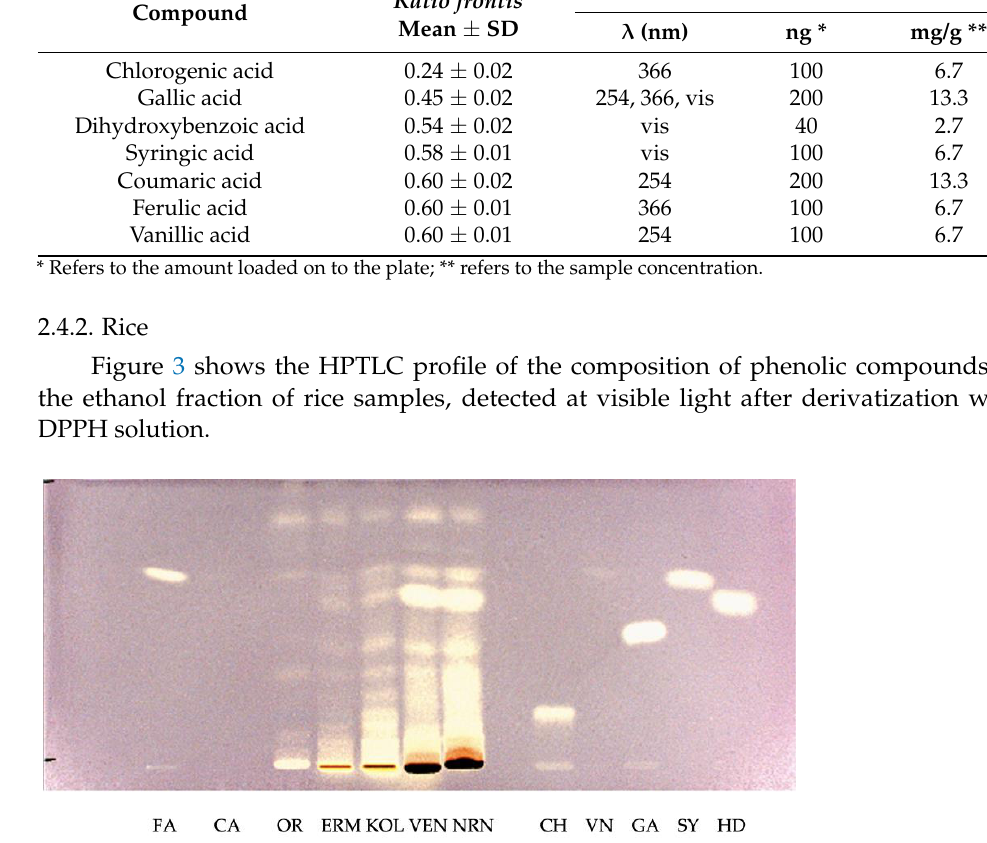
Figure 3. HPTLC patterns of the composition of phenolic compounds of the ethanol fraction of rice varieties detected at visible light after derivatization with DPPH solution. Standard phenolic acids are run in parallel. FA: ferulic acid, CA: coumaric acid, CH: chlorogenic acid, VN: vanillic acid, GA: gallic acid, SY: syringic acid, HD: dihydroxybenzoic acid, OR: Originario brown, ERM: Ermes